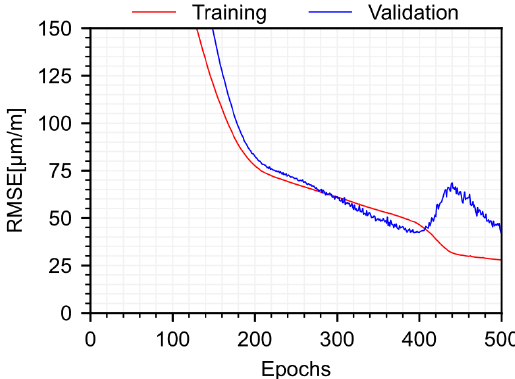
Figure 6. Training and validation losses for the total strain